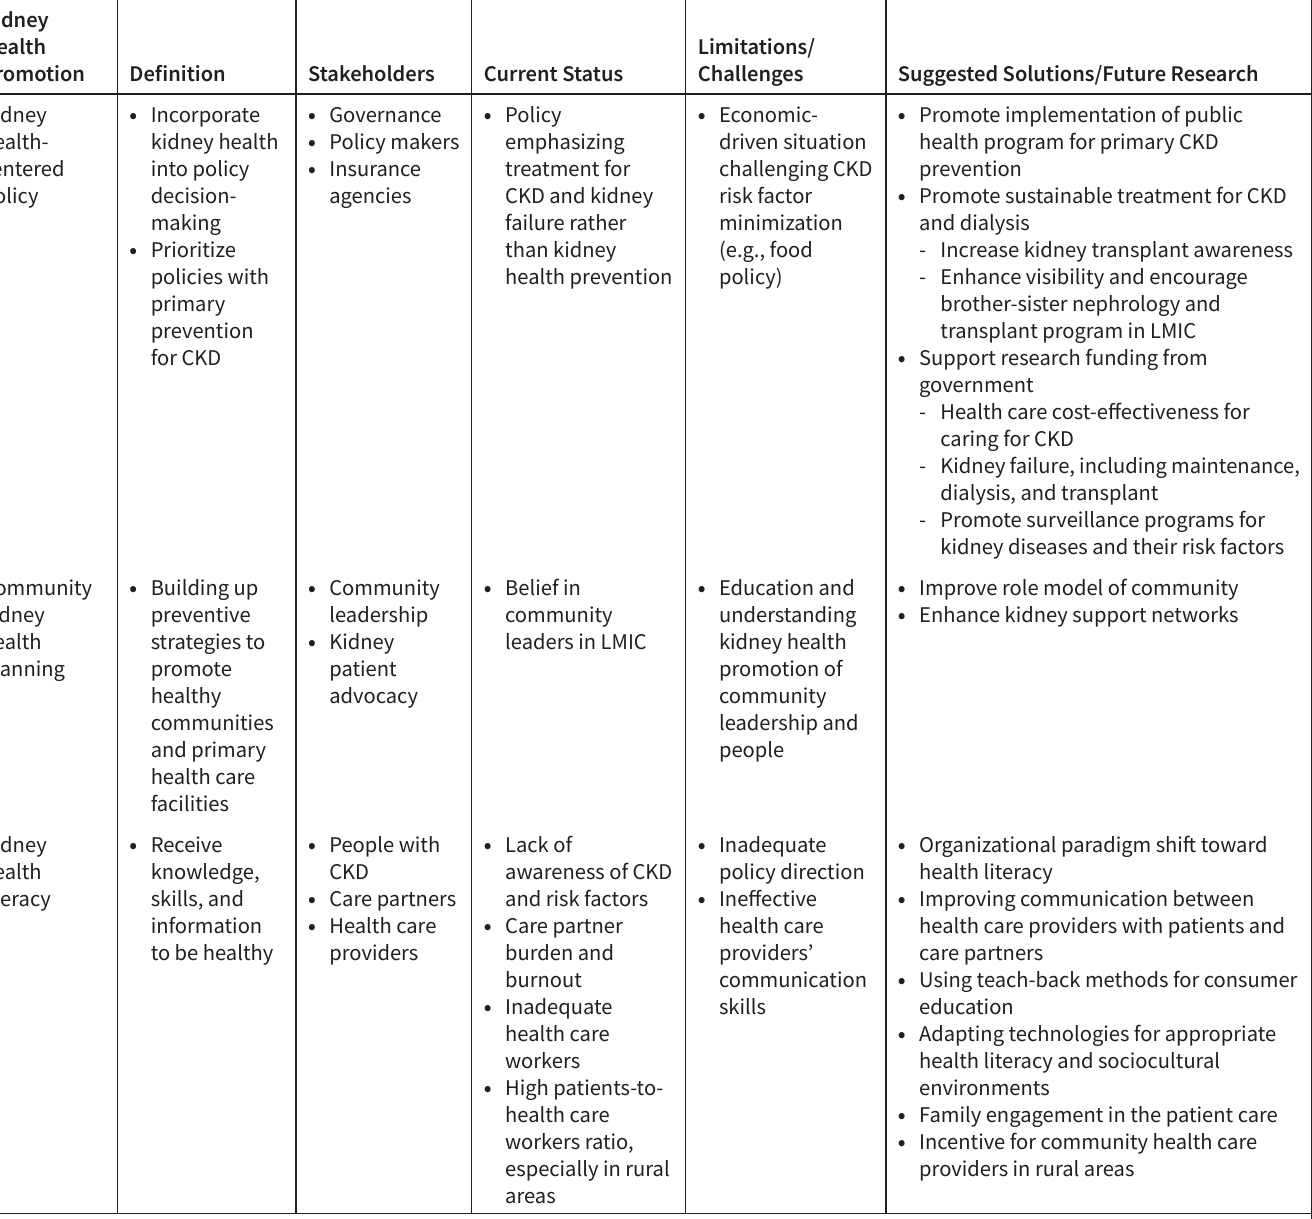
Table 1. Summary Characteristics of Kidney Health Promotion, Involving Kidney Health-Centered Policy, Community Kidney Health Planning, and Kidney Health Literacy, and Proposed Future